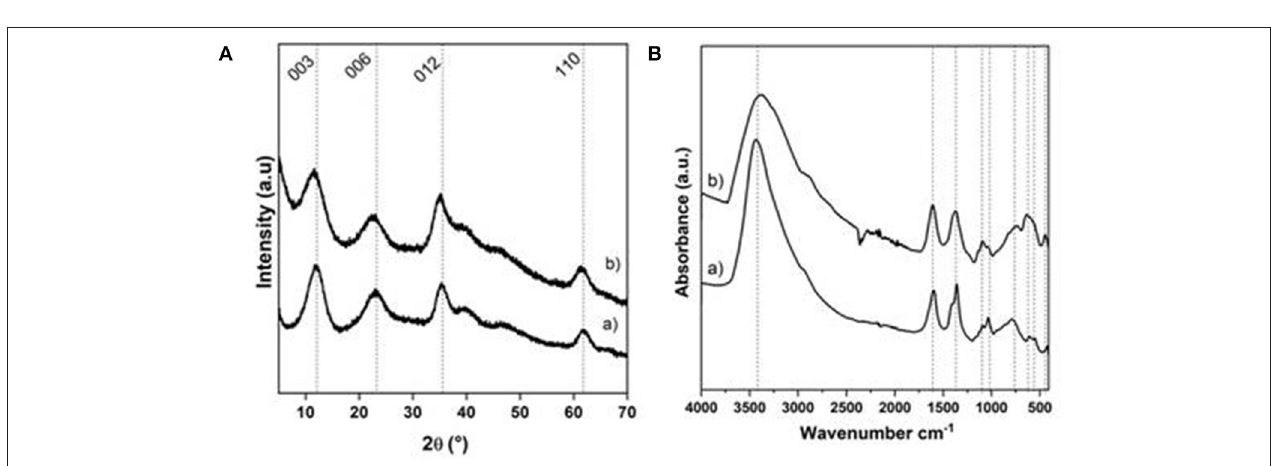
FIGURE 2 | SEM images of (A–D) NiAl@Alg-Ca beads and (E–H) NiAl@Alg beads dried upon CO 2 supercritical conditions.